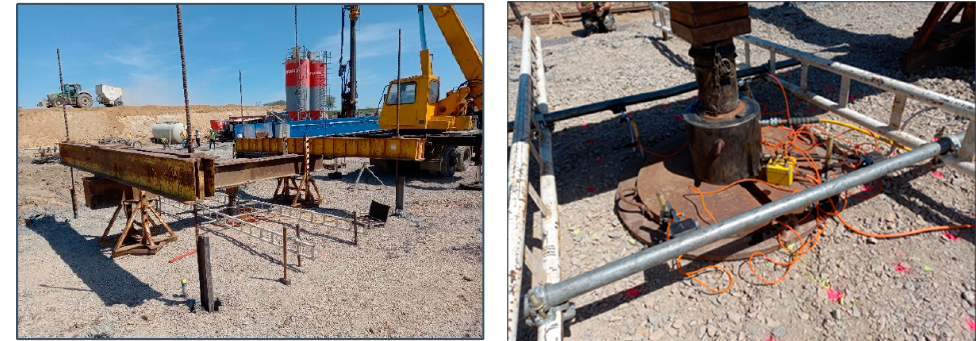
Figure 22. Aggregate ( left ) and geogrid ( right ) used to construct stabilised working platform [139].